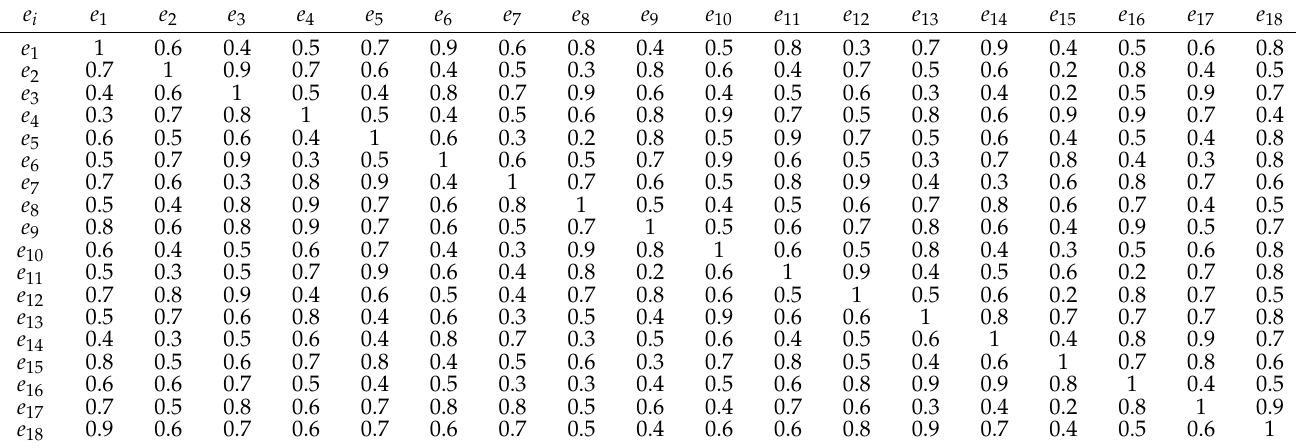
Table 3. Trust information among decision